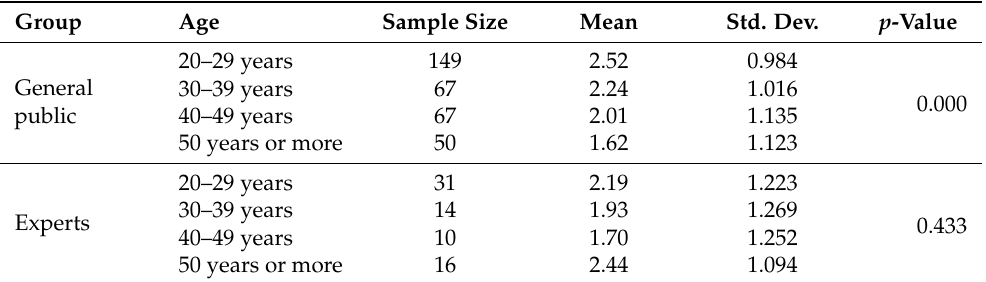
Table 4. Perceptions of the development of wind turbines technology, grouped by age. Group Age Sample Size Mean